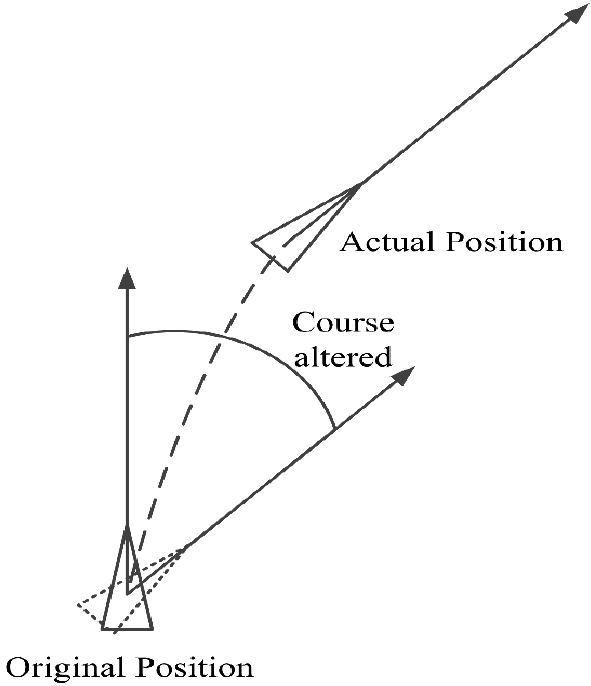
Figure 3. The illustration of position change after altering course.